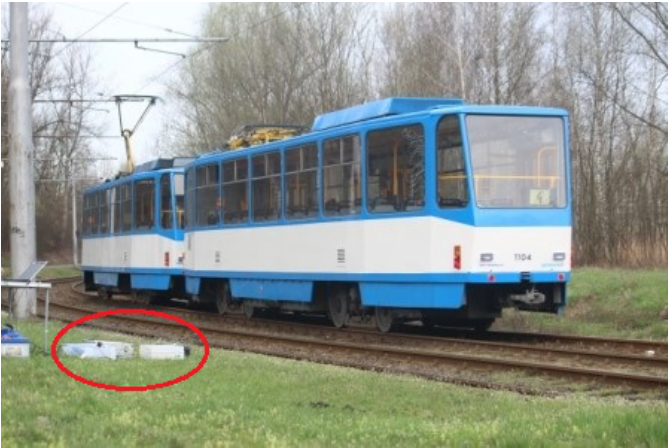
Figure 10. Photographs of the CKD T6A5 (two cars) tram directly from the measurement location (summer). The location of the sensors is marked in